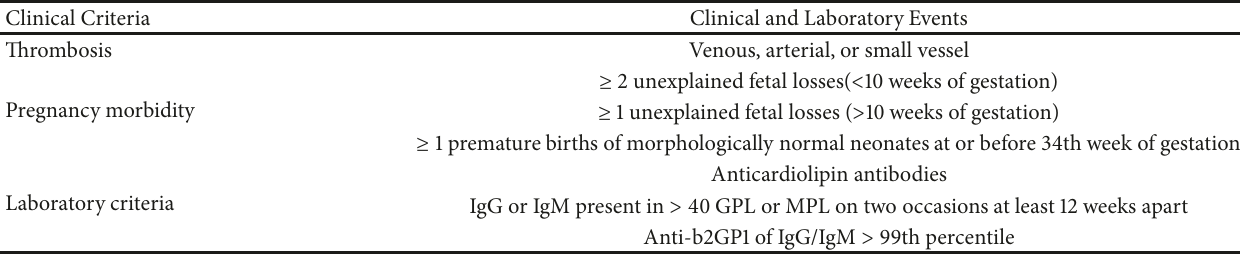
Table 1: International consensus statement on criteria for the classification of the antiphospholipid